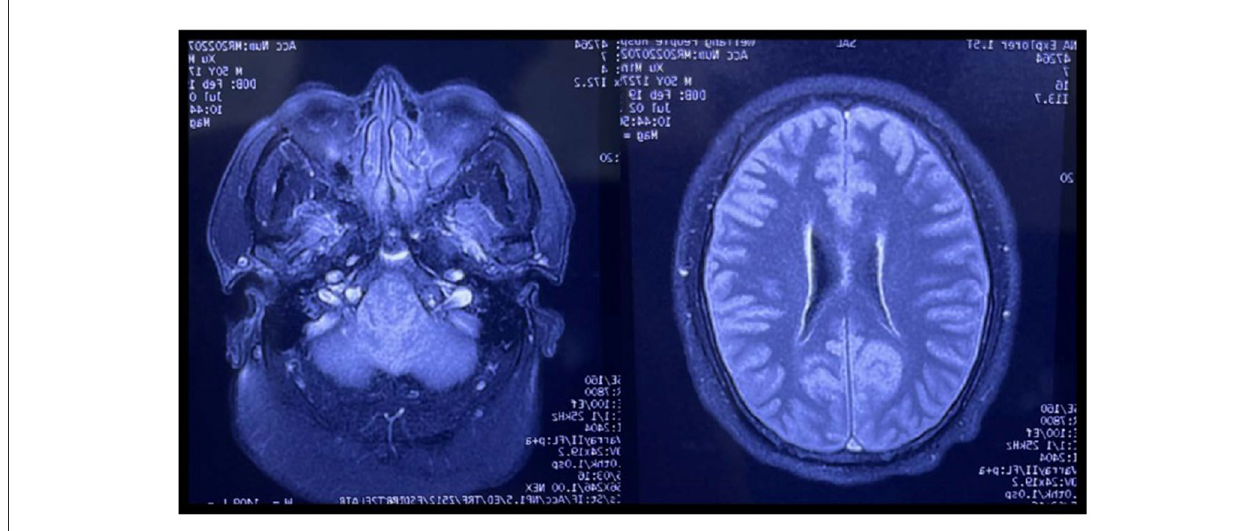
FIGURE3 Craniocerebral magnetic resonance examination results of the patient.